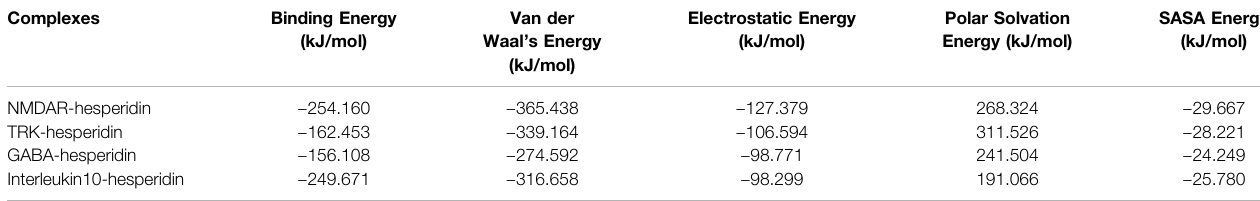
TABLE 2 | Binding energy and its constituents calculated through MM-PBSA calculations for the protein-ligand complexes. Complexes Binding Energy (kJ/mol)